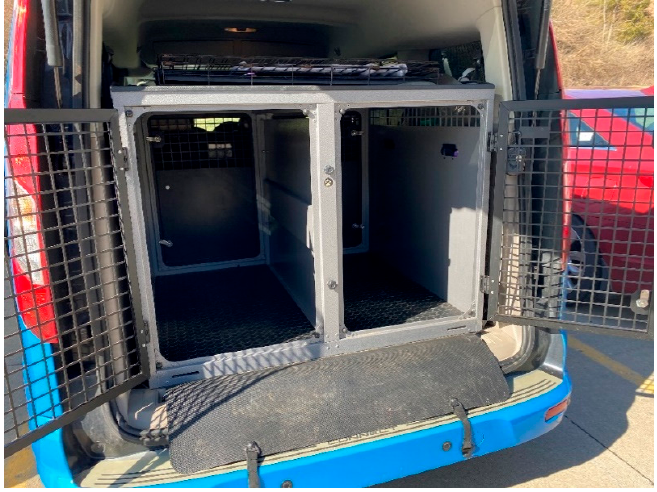
Figure 2. Cargo van with dual crate system and removable center divider.